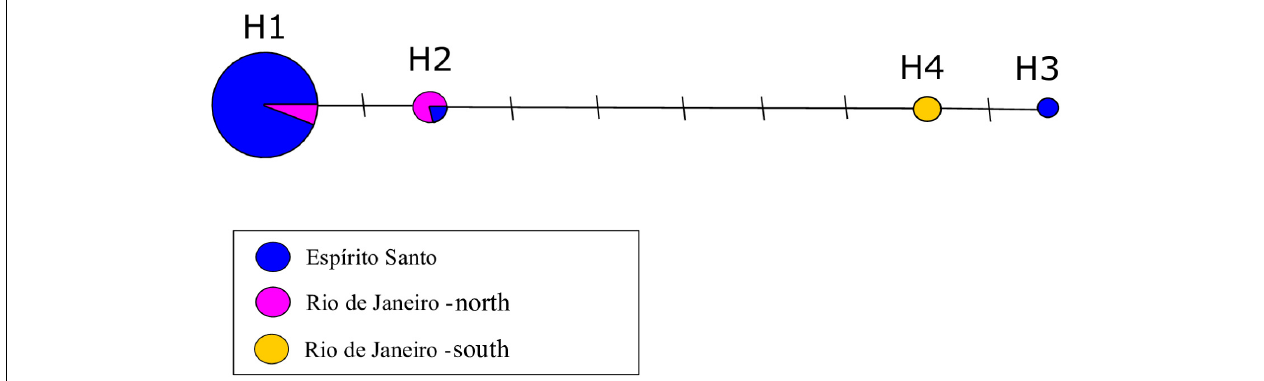
FIGURE 2 | Haplotype network of the mitochondrial DNA control region (D-loop) for Pontoporia blainvillei ( N = 57, 350 bp). Each circle corresponds to a haplotype and its size is proportional to its frequency in the population. Different colors represent the sampling locations. Each line between the haplotypes corresponds to the number of nucleotide differences between the haplotypes.